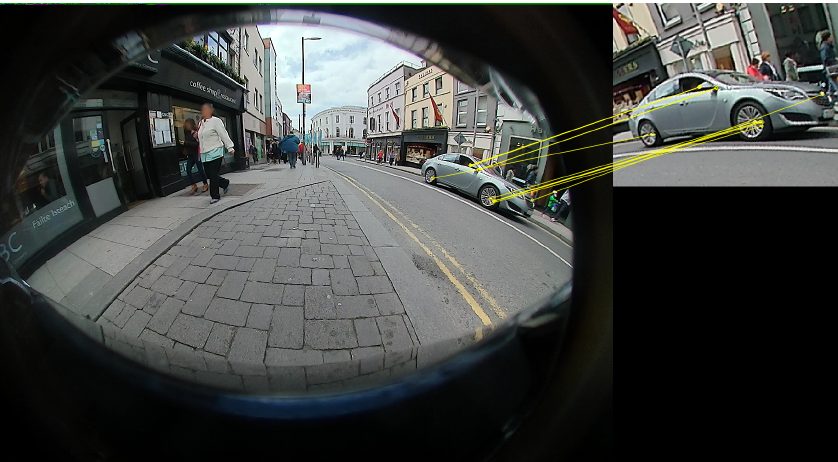
Figure 8. Illustration of ORB based feature